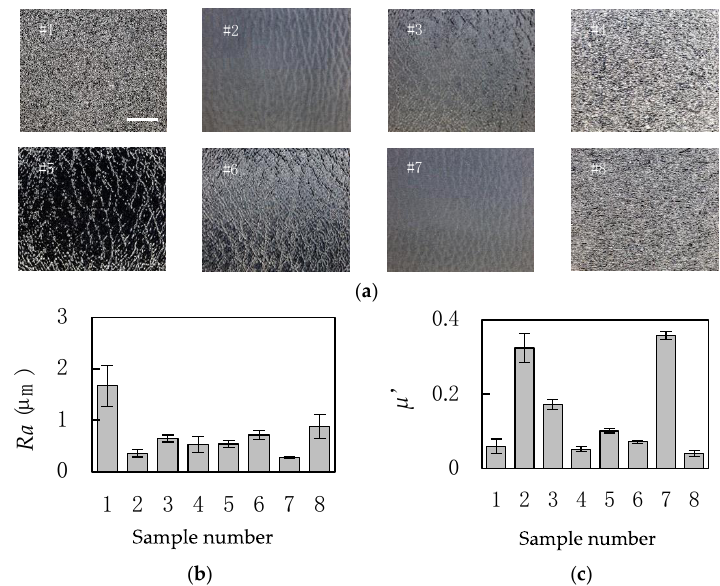
Figure 1. The information of plastic test samples. ( a ) The enlarged views (Scale bar: 5 mm); ( b ) arithmetic average roughness, Ra (mean ± SD, n = 10); and ( c ) dynamic friction coefficient, µ ’ (mean ± SD, n = 10). Materials of the plates are: #1; polystyrene, #2; unknown, #3; polypropylene, #4; polyethylene, #5; polycarbonate, #6; polymethyl methacrylate, #7; unknown, #8; polyethylene.